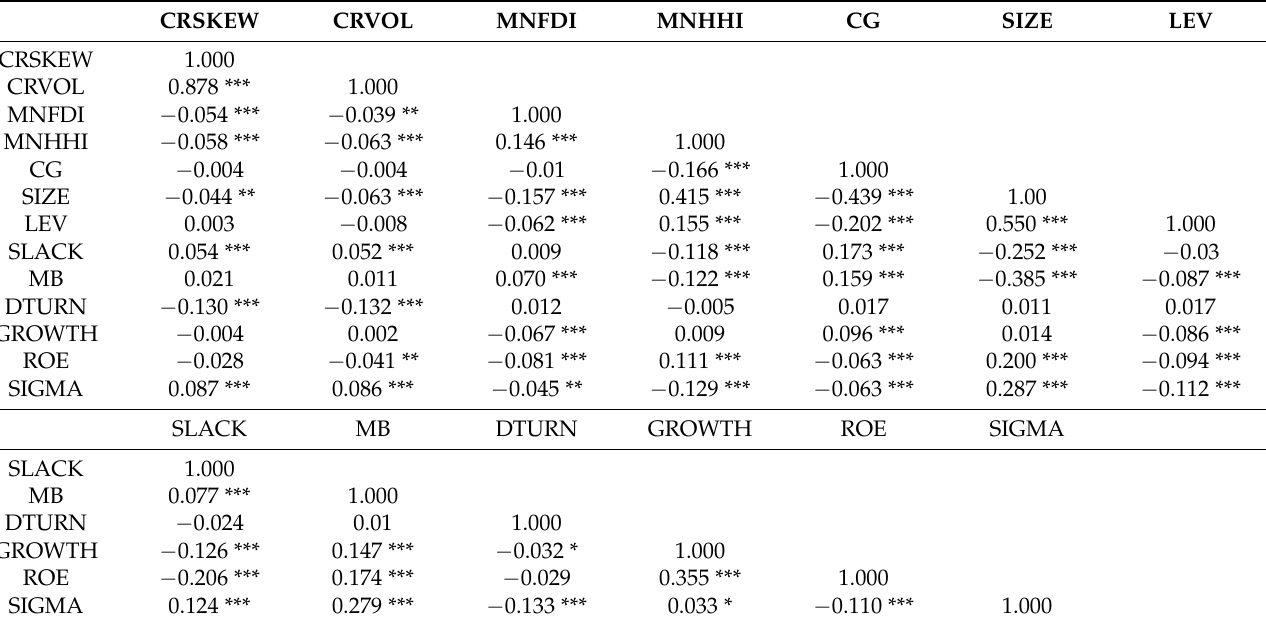
Table 3. Correlation Matrix. Figures in parentheses are t-statistics. ***, ** and * denote statistical significant at the 1%, 5% and 10% level,